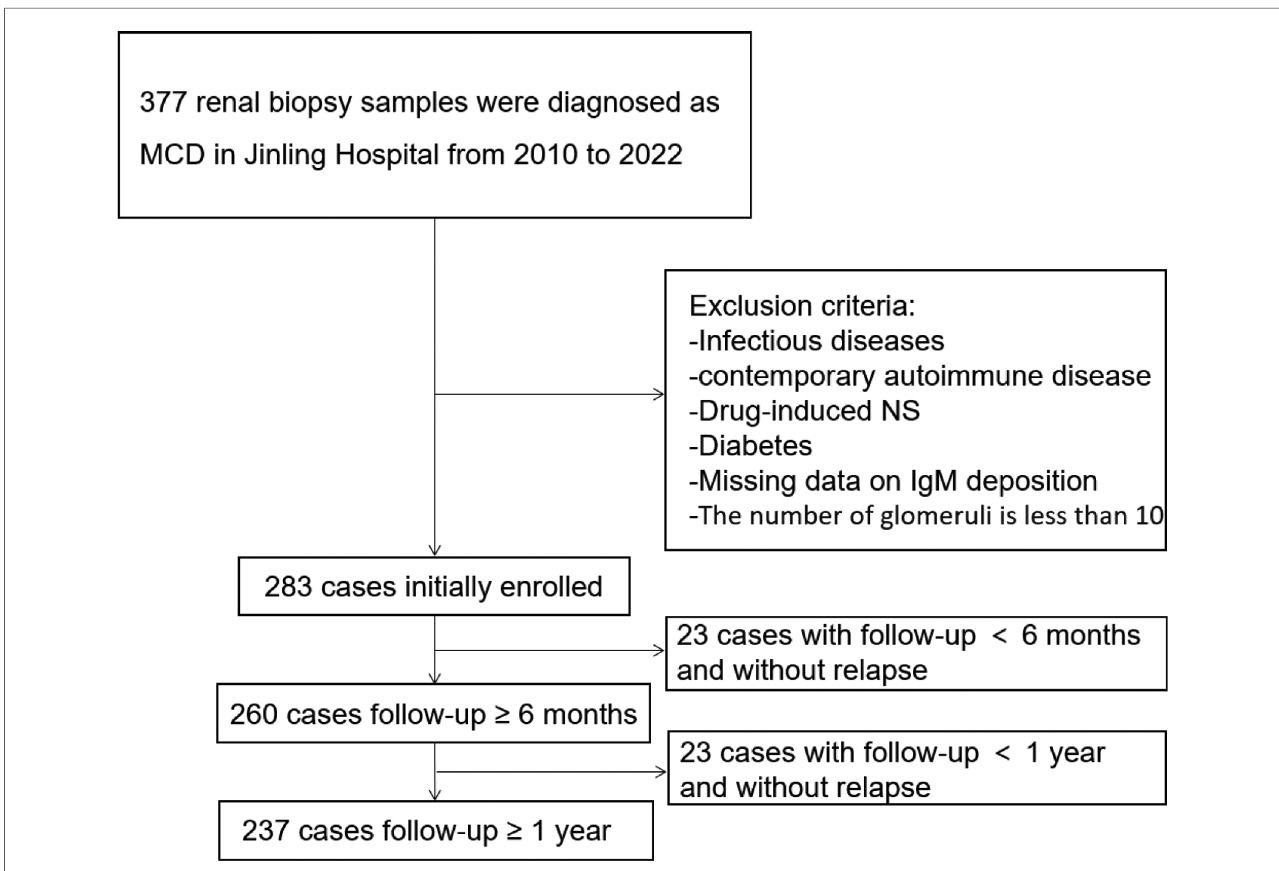
Table 1 . Compared the two groups, there were no statistically signi fi cant differences in age of onset, gender, BMI, hypertension, duration, serum IgG, serum IgM, serum C3, proteinuria levels, hematuria cases, Acute Kidney Injury (AKI), total glomeruli, ATI and CTI (All P > 0.05). No severe ATI and moderate to severe CTI were observed in the renal pathology of all MCD